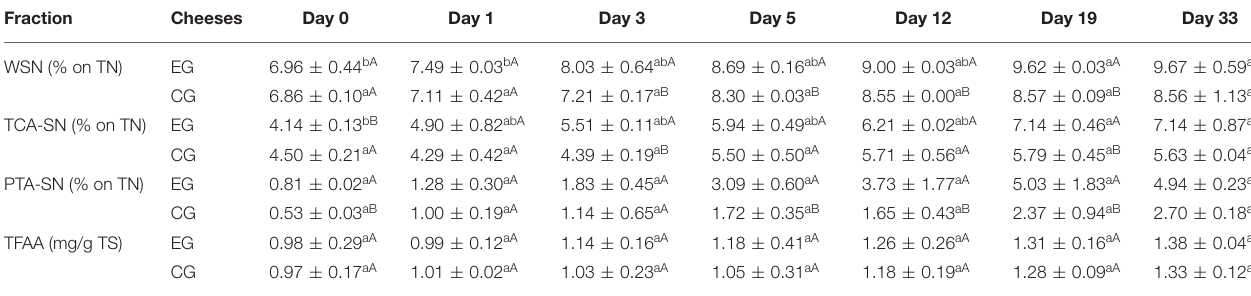
TABLE 2 | Changes of nitrogenous fractions during cheese ripening. Fraction